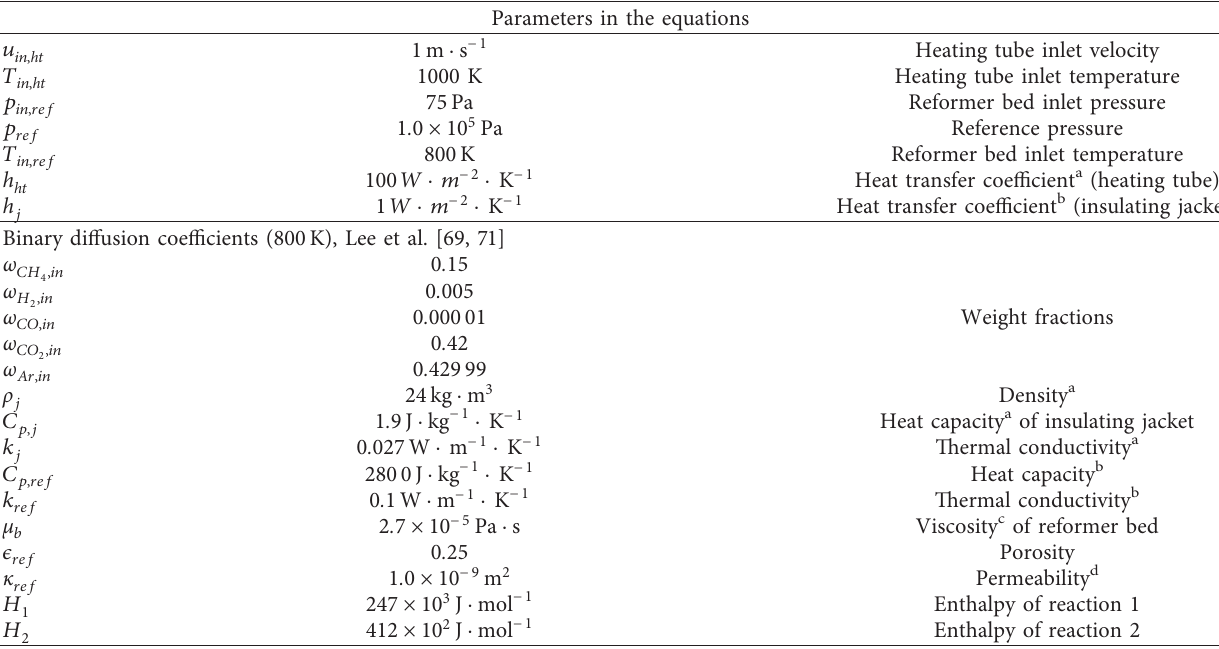
Table 2: Parameters used in numerical studies.